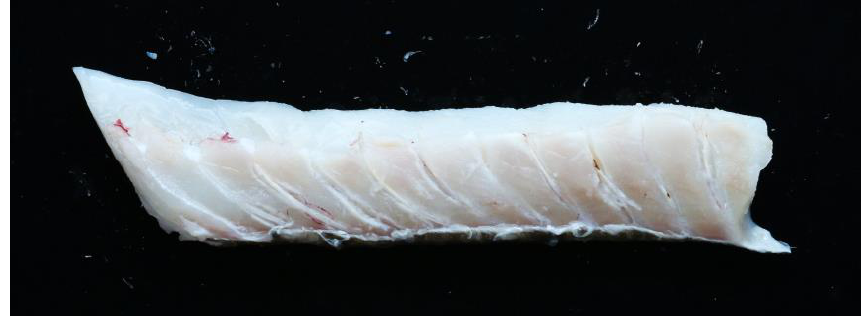
Figure 13. Example of a cod fillet treated with a 1 MHz transducer at a 45 mm distance, with continuous treatment along the row of bones at a speed of 1 mm/s. The fillet was cut along the row of bones to visualize the treatment effect. Note that some bones have become detached from the muscle, and that some have been “burned”, resulting in a brown color. The image represents a “best case” with regard to the treatment effect, and is not representative of all fillets treated.